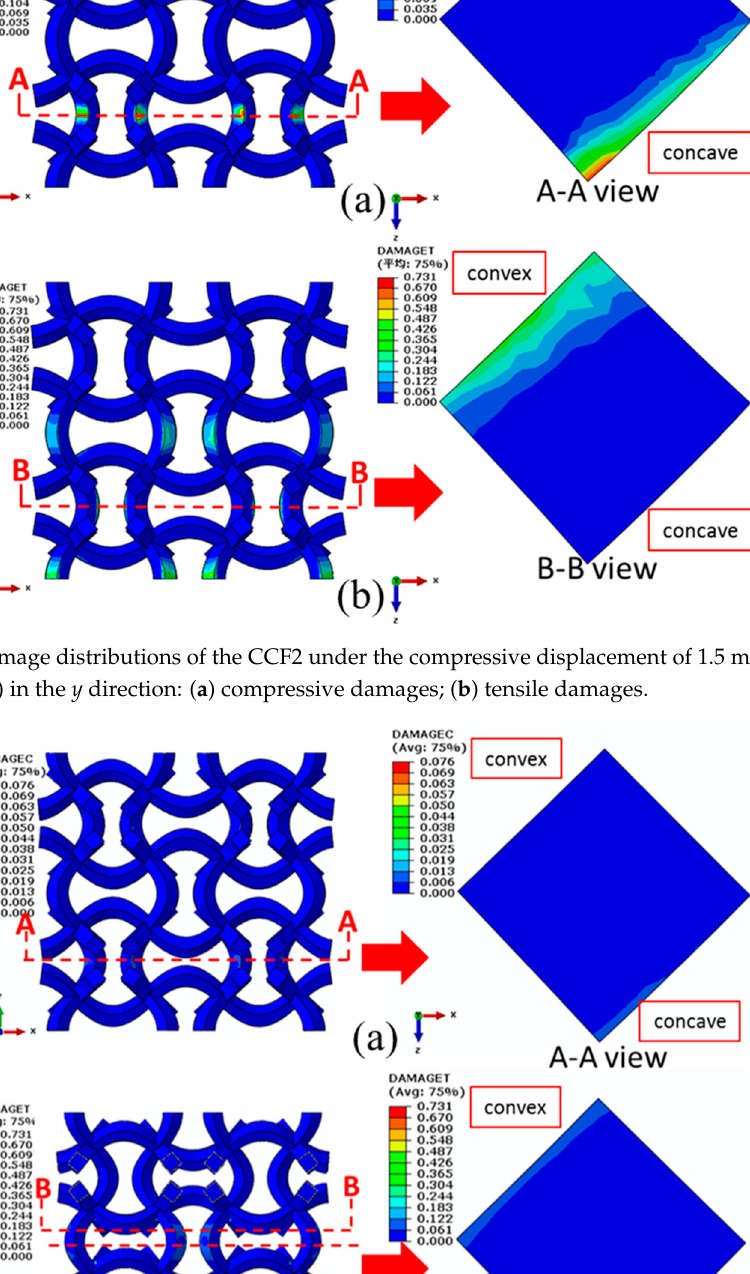
( b ) Figure 16. The maximum damages of the cross sections of the vertically placed cell edges under different compressive displacements: ( a ) compressive damages; ( b ) tensile damages. 7. Conclusions The orthogonal isotropic NPR CCF are a typical kind of mechanical metamaterials, which have great potential applications in the fields of mechanical and aerospace engineering. Systematic and deep understanding of their mechanical properties plays a vital role for their practical engineering